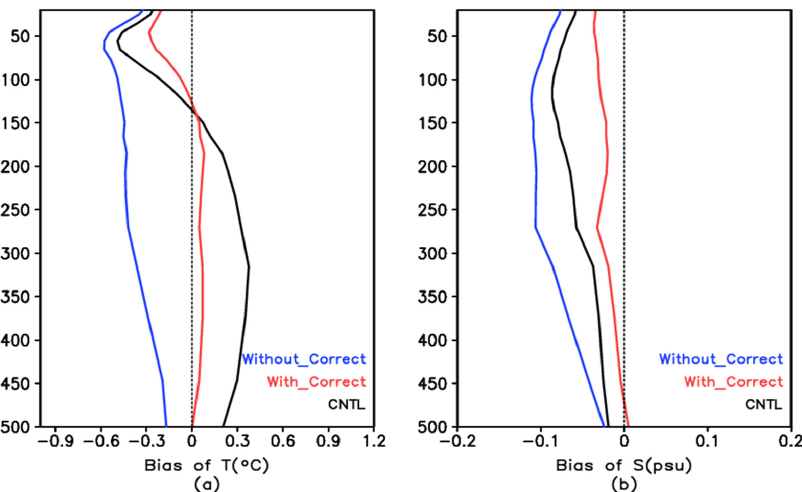
Figure 11. Vertical distribution of the biases of temperature ( a ) and salinity ( b ) over the period 1993–1999 for the southern Indian and southern Pacific oceans.